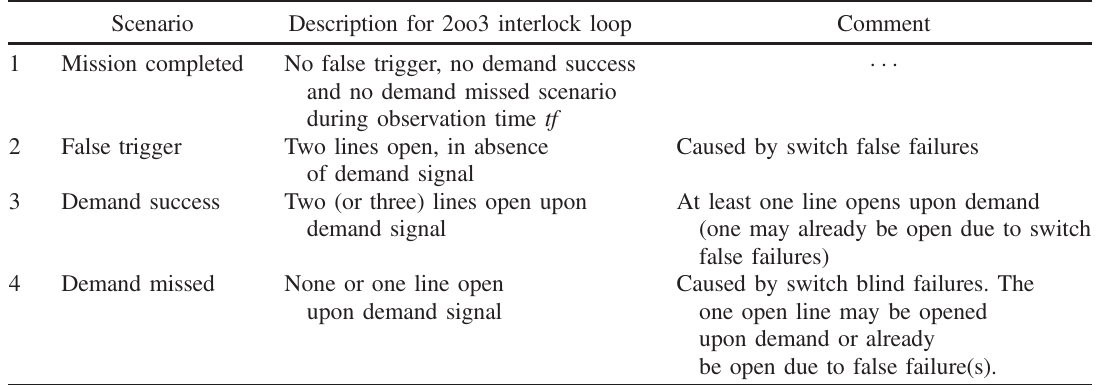
TABLE IV. Definition of scenarios for 2oo3 interlock loop architecture.